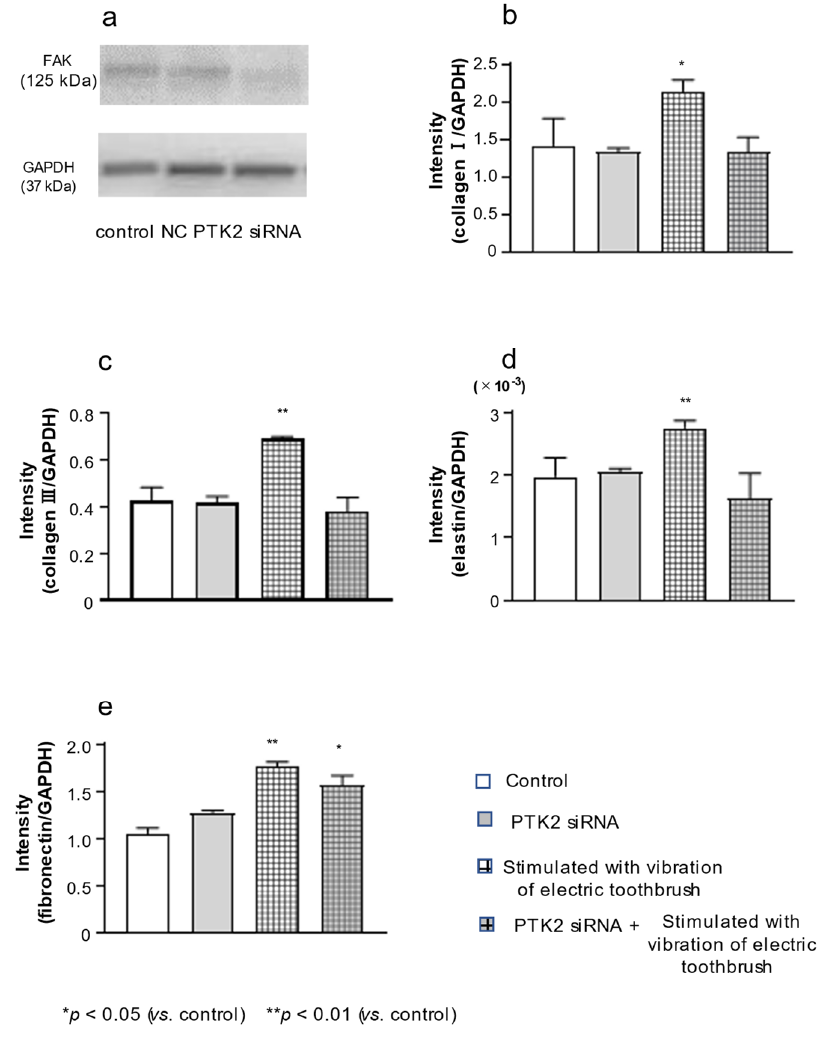
Figure 5. Effect of PTK2 siRNA on the expression of FAK, type III collagen, elastin, and fibronectin in gingival fibroblasts. HGnFs were transfected with PTK2 siRNA or its negative control (NC) ( a ). The mRNA expression of col III, elastin, and FN was quantified 5 days after treatment with PTK2 siRNA ( b – e ). Each bar indicates mean ± standard deviation (SD) of five independent experiments. * p < 0.05, ** p < 0.01.